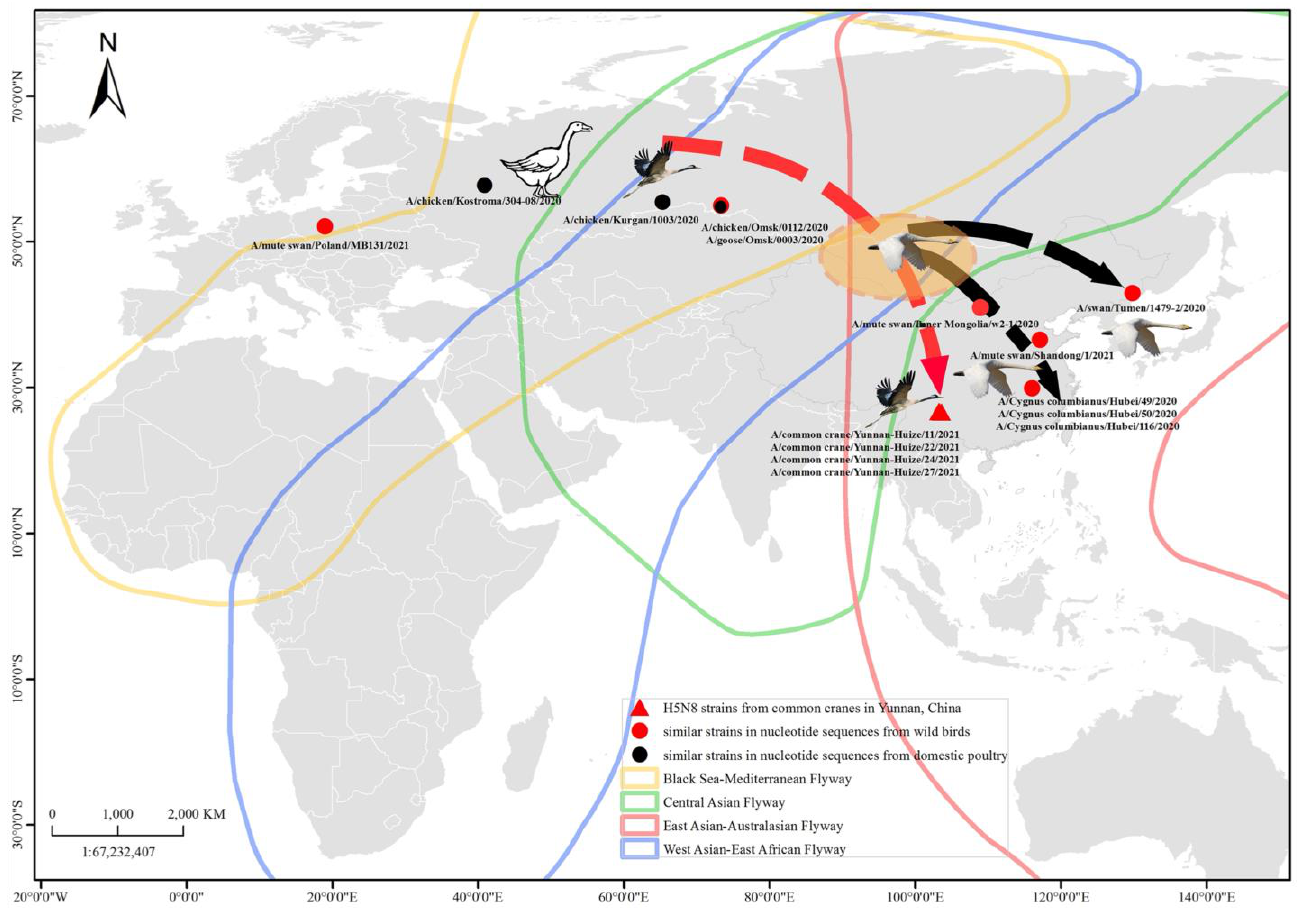
Figure 1. The spatial distribution of H5N8 AIVs isolated in this study and the proposed transmission relationship amongst them and their homology. The red triangle denotes the H5N8 strains identified in this study from common cranes wintering in Yunnan, China. The red and black circles represent the homologous strains from wild birds and domestic poultry, respectively. The red dashed line indicates the overwintering flight route of common cranes from Siberia, Russia, to Yunnan, China; and the black dotted line indicates the overwintering flight route of swans from Mongolia to Hubei, China. The orange-shaded oval area denotes the main stopovers for common cranes and the breeding site for swans. The map was constructed using ArcGIS Desktop version 10.2.